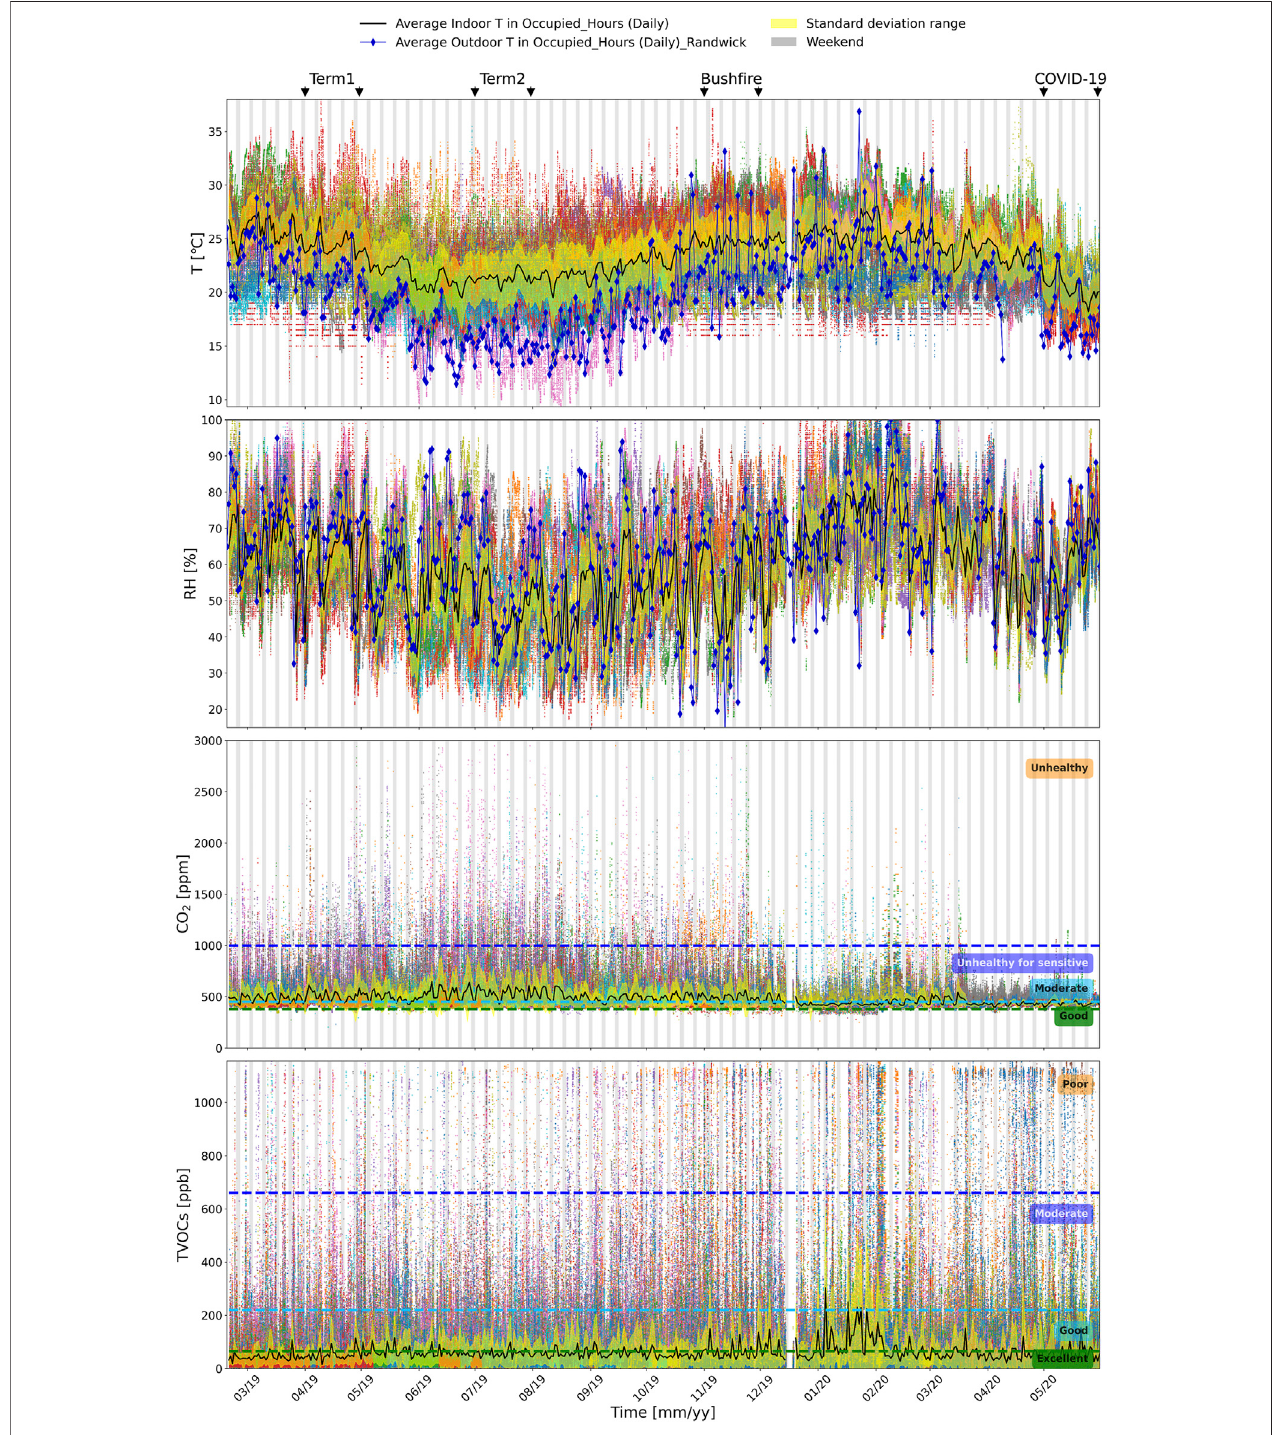
FIGURE 3 | Time trends of temperature, relative humidity, CO 2 and TVOCs between February 2019 and JuneMay 2020. Outdoor measurements are taken from the DPIE station located in Randwick. A blackout period occurred between the 14th and the December 21, 2019, causing all MyAirs to stop recording.